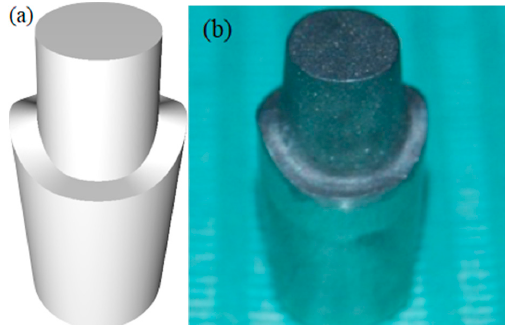
Figure 1. A customized Cr-Co implant abutment was manufactured according to the STL